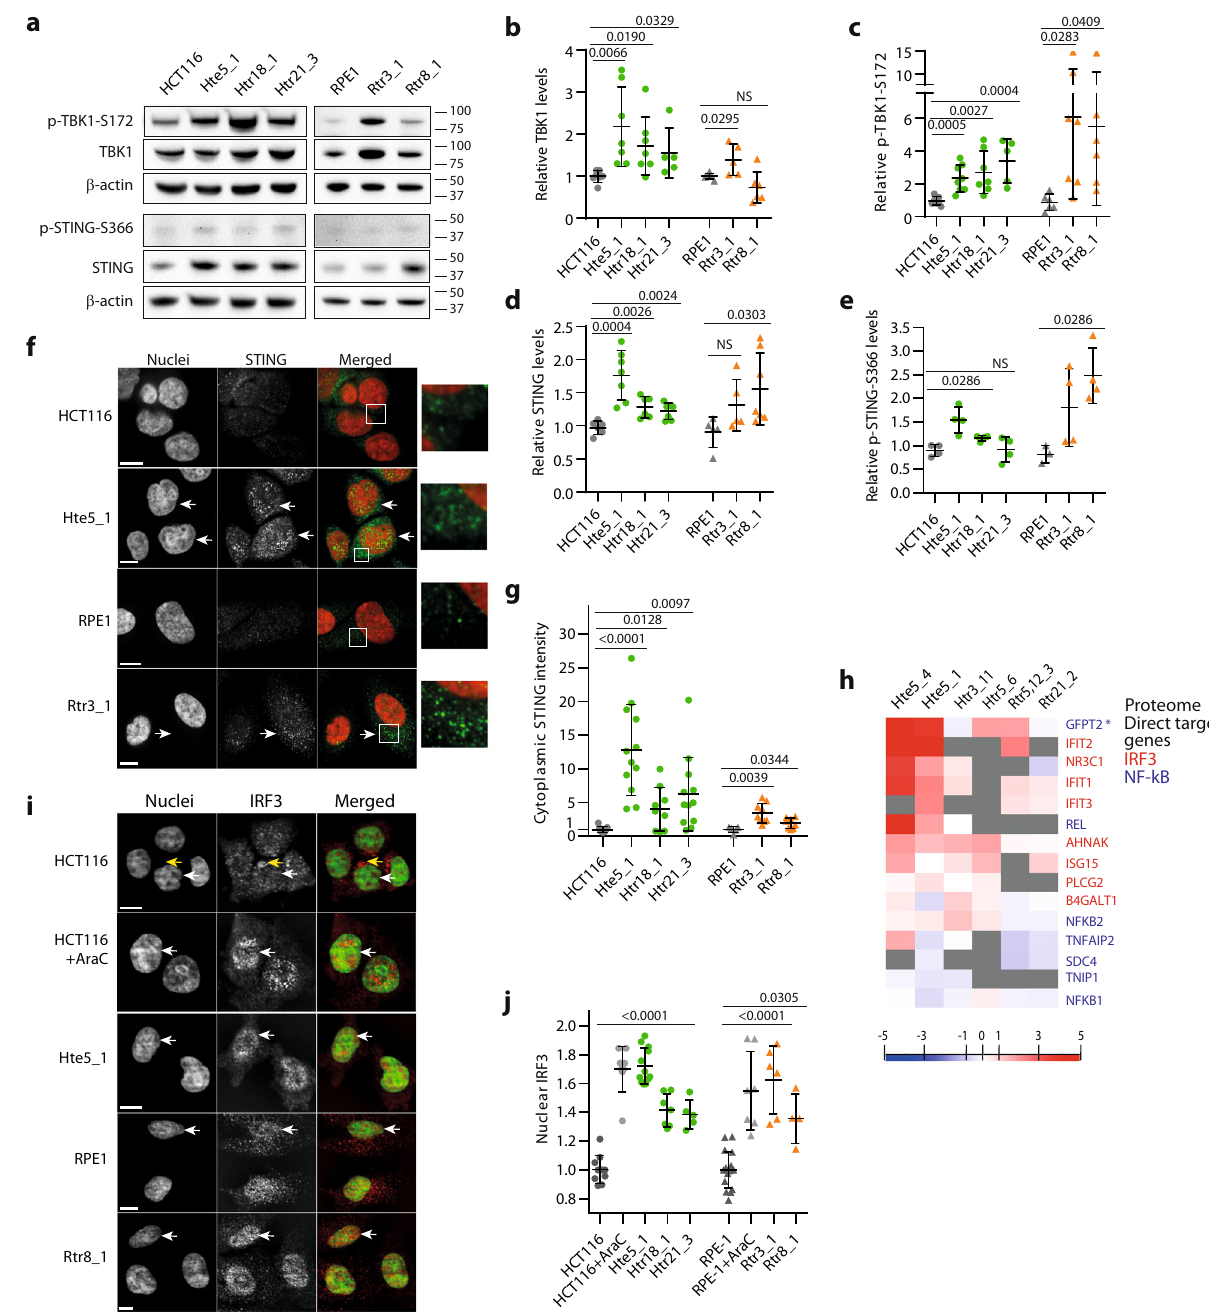
Fig. 3 The cGAS – STING – TBK1 – IRF3 pathway is constitutively active in trisomic cells. a Representative image of immunoblotting of TBK1, p-TBK1 – S172, STING, and p-STING – S366. β -actin serves as a loading control. Quanti fi cation of TBK1 ( b ), p-TBK1 – S172 ( c ), STING ( d ), and p-STING – S366 ( e ) by signal intensity of the protein bands on the gel. The signal was normalized to parental controls. Each point represents the mean from one independent biological experiment, 4 – 8 experiments were performed in each cell line. f Immuno fl uorescence images of STING localization. White arrows indicate increased clustering in trisomic cells. g Quanti fi cation of cytoplasmic STING fl uorescence intensity. Delta MFI from the total cell and the nucleus was calculated for the cytoplasmic signal. At least 200 cells were analyzed in each independent biological experiment, means of each experiment are shown, and 5 – 12 experiments were performed in each cell line. h Proteome analysis of IRF3 and NF-kB targets. The heat map shows fold changes in trisomic and tetrasomic cells compared with parental diploid cells. * GFPT2 is located on chromosome 5, which may explain its increased abundance in cell lines with trisomy 5. i Examples of immuno fl uorescent images of IRF3 localization. White arrows point to the nuclei. Yellow arrow indicates perinuclear space occupied by IRF3 protein . j Quanti fi cation of the relative intensity of the nuclear IRF3 signal. Delta MFI data, characterizing IRF3 abundance in the nucleus, were quanti fi ed as a difference between nuclear and cytoplasmic MFI for each individual cell. Delta MFI data were plotted after normalization to the parental diploid controls. Diploid cells treated with DNA-damaging agent AraC were used as a positive control. At least 1000 cells were analyzed per each cell line, means of each experiment are shown, and 4 – 17 independent experiments for each cell line were performed. Unpaired t-test was used for statistical analysis of all the data; in e Mann – Whitney test was applied. Individual measurements, mean values, p -values, and standard deviations are shown in the plots. Statistical evaluation is summarized in Supplementary table 4, source data is available in Supplementary Data 5. Scale bar 10 µ